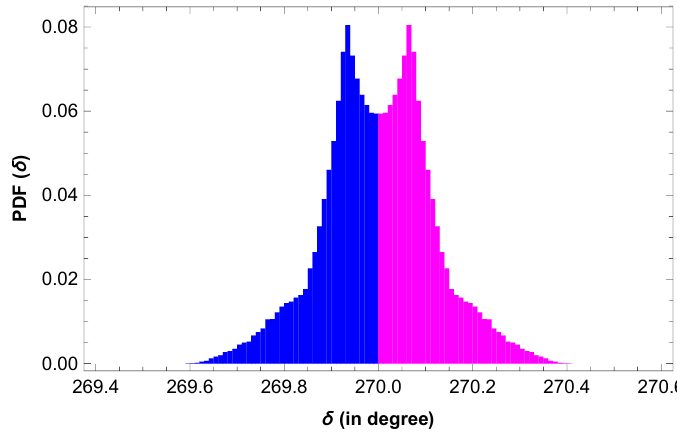
Figure 1 . Probability distribution of the Dirac CP phase (cid:14) for normal mass ordering. It is evident that the values which are very close to 270 (cid:14) are most probable. To be numerically precise, R 270 (cid:6) 0 : 2